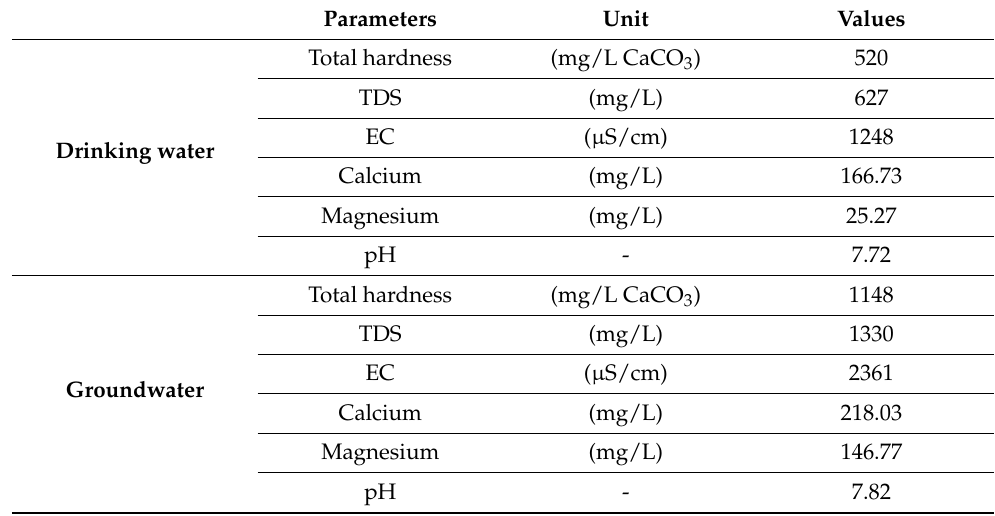
Table 2. Drinking water and groundwater sample